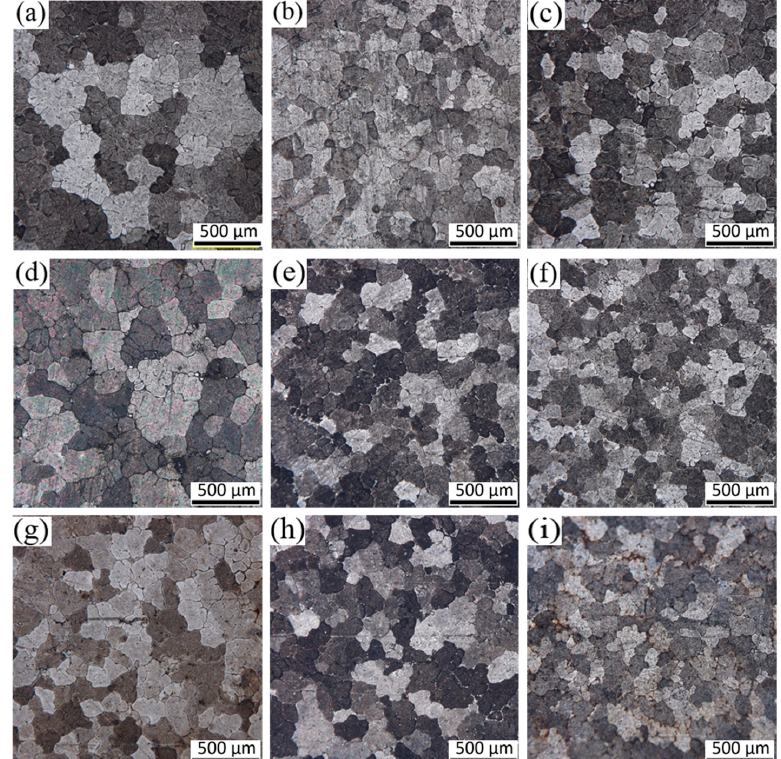
Figure 5. Microstructure of obtained under different processing conditions: ( a ) Center of ingot without ultrasonic; ( b ) 1/2 radius of ingot without ultrasonic; ( c ) edge of ingot without ultrasonic; ( d ) center of ingot by L-shaped ultrasonic; ( e ) 1/2 radius of ingot by L-shaped ultrasonic; ( f ) edge of ingot by L-shaped ultrasonic; ( g ) center of ingot by straight-rod ultrasonic; ( h ) 1/2 radius of ingot by straight-rod ultrasonic; and ( i ) edge of ingot by straight-rod ultrasonic.